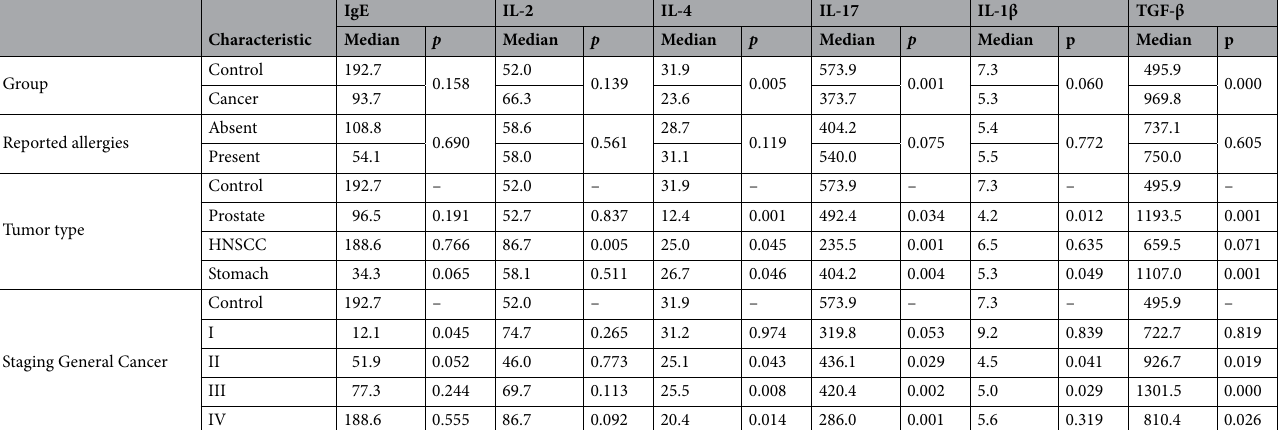
and cancer staging. (Table 2). There was no difference in the values of cytokine medians between the two groups, based on IgE concentra- tions or on the classification of IgE in the normal, borderline, or high categories (p > 0.05) (Table 3). There was a weak correlation between most cytokines and IgE levels in both groups (Spearman’s correlation factors < 0.4 for most groups) 45 . A moderate correlation was identified only in the prostate adenocarcinoma group for TGF-β